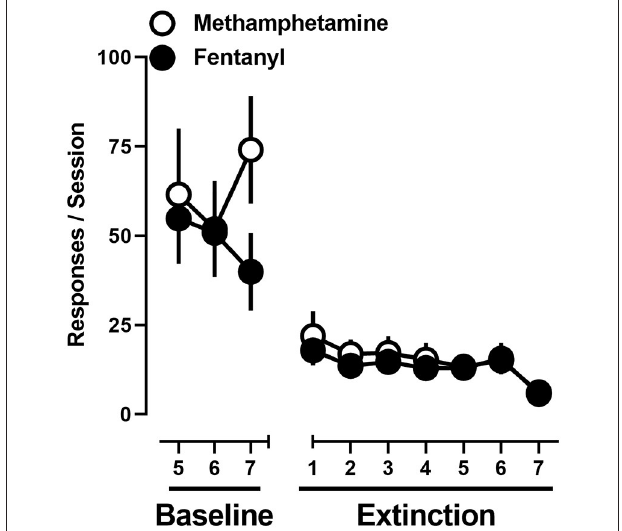
FIGURE 5 | Responses made on the methamphetamine (open circles) and fentanyl (filled circles) levers on the final 3 days of concurrent access to methamphetamine and fentanyl self-administration, and extinction conditions. Data represent the mean ± S.E.M., and each point represents 12 rats.